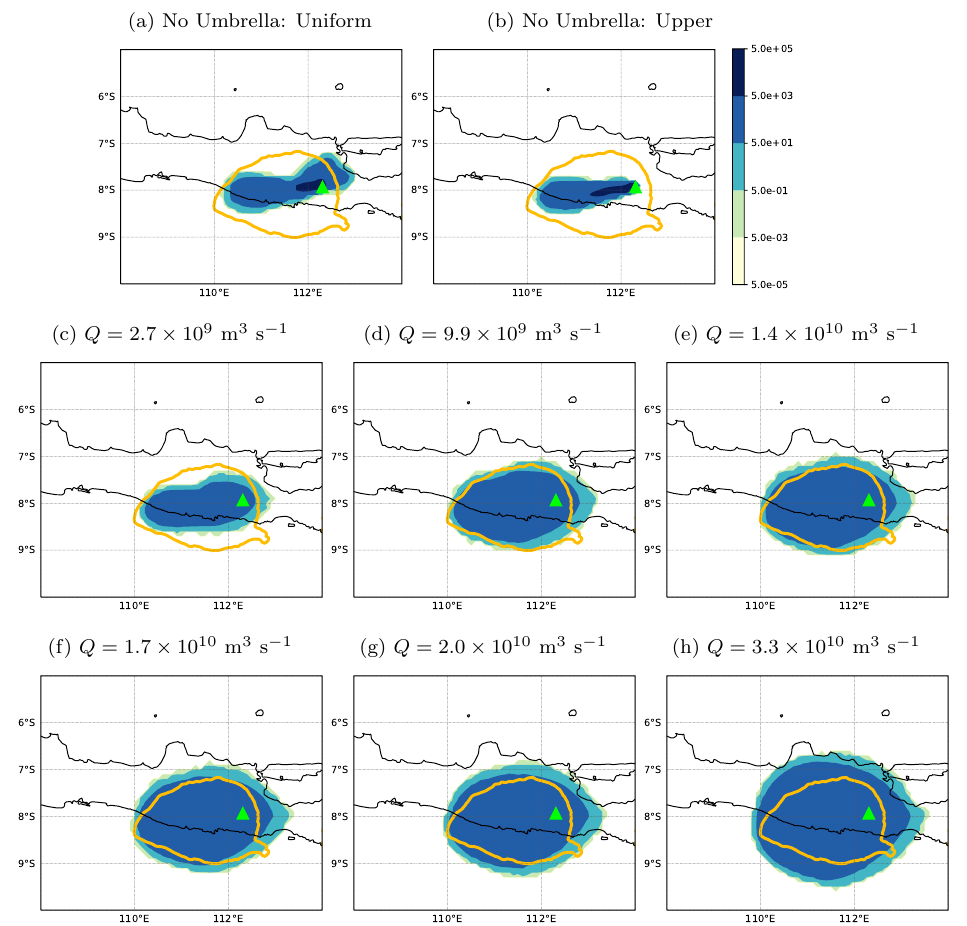
Figure 2. Modelled ash column loads (filled contours in g m − 2 ) and 11 µ m brightness temperature satellite observations (orange open contour: 210 K) of the Kelud umbrella cloud at 18:19 UTC on 13 February 2014 (2 h, 10 min after the eruption start). Model simulations in ( a , b ) do not use the umbrella cloud parameterisation and are described in Section 5. Simulations in ( c – h ) use the umbrella parameterisation with different estimates of the volume flow rate, Q . The volcano location is marked by a green triangle. Satellite data are from MTSAT